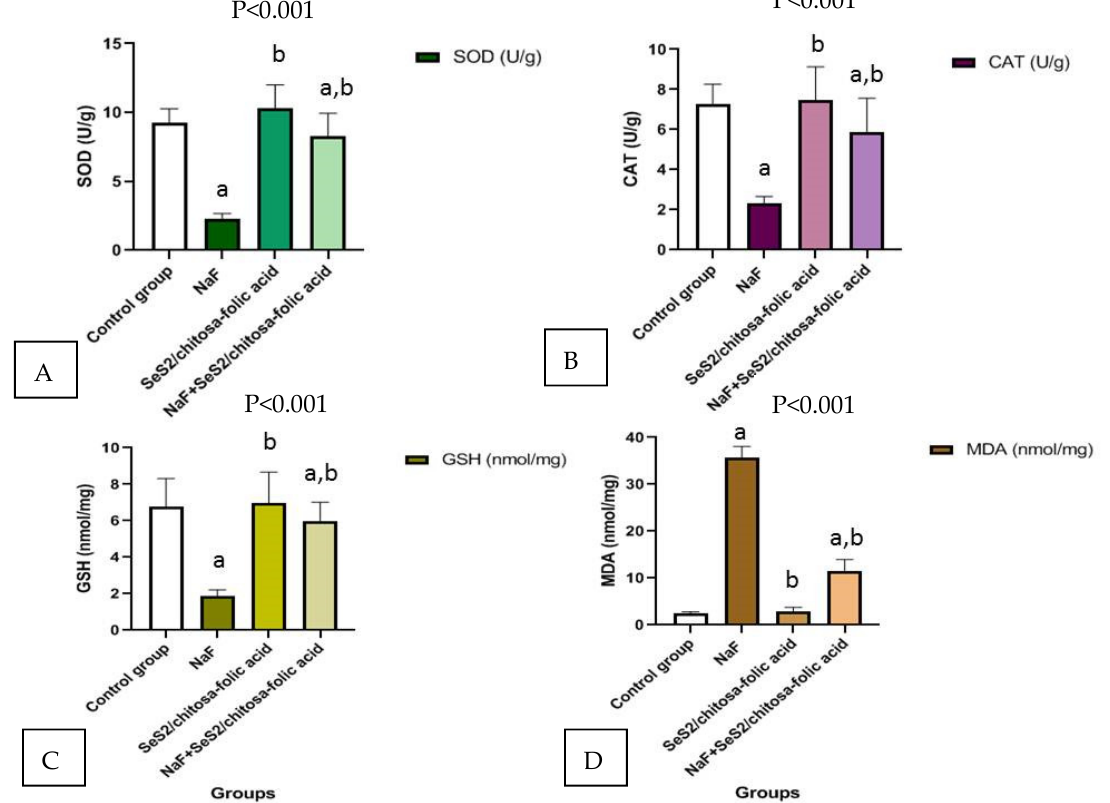
Figure 9. Se/chitosan-folic acid novel complex decreased MDA, GSH, SOD, and CAT in the liver tissues of sodium fluoride NaF-exposed male rats. Data are mean ± SEM, n = 10. ( A ) SOD enzyme; ( B ) CAT enzyme ( C ); GSH enzyme ( D ); MDA (marker of lipid peroxidation) Where (a) is significant to the control group, (b) is significant to the NaF treated group.